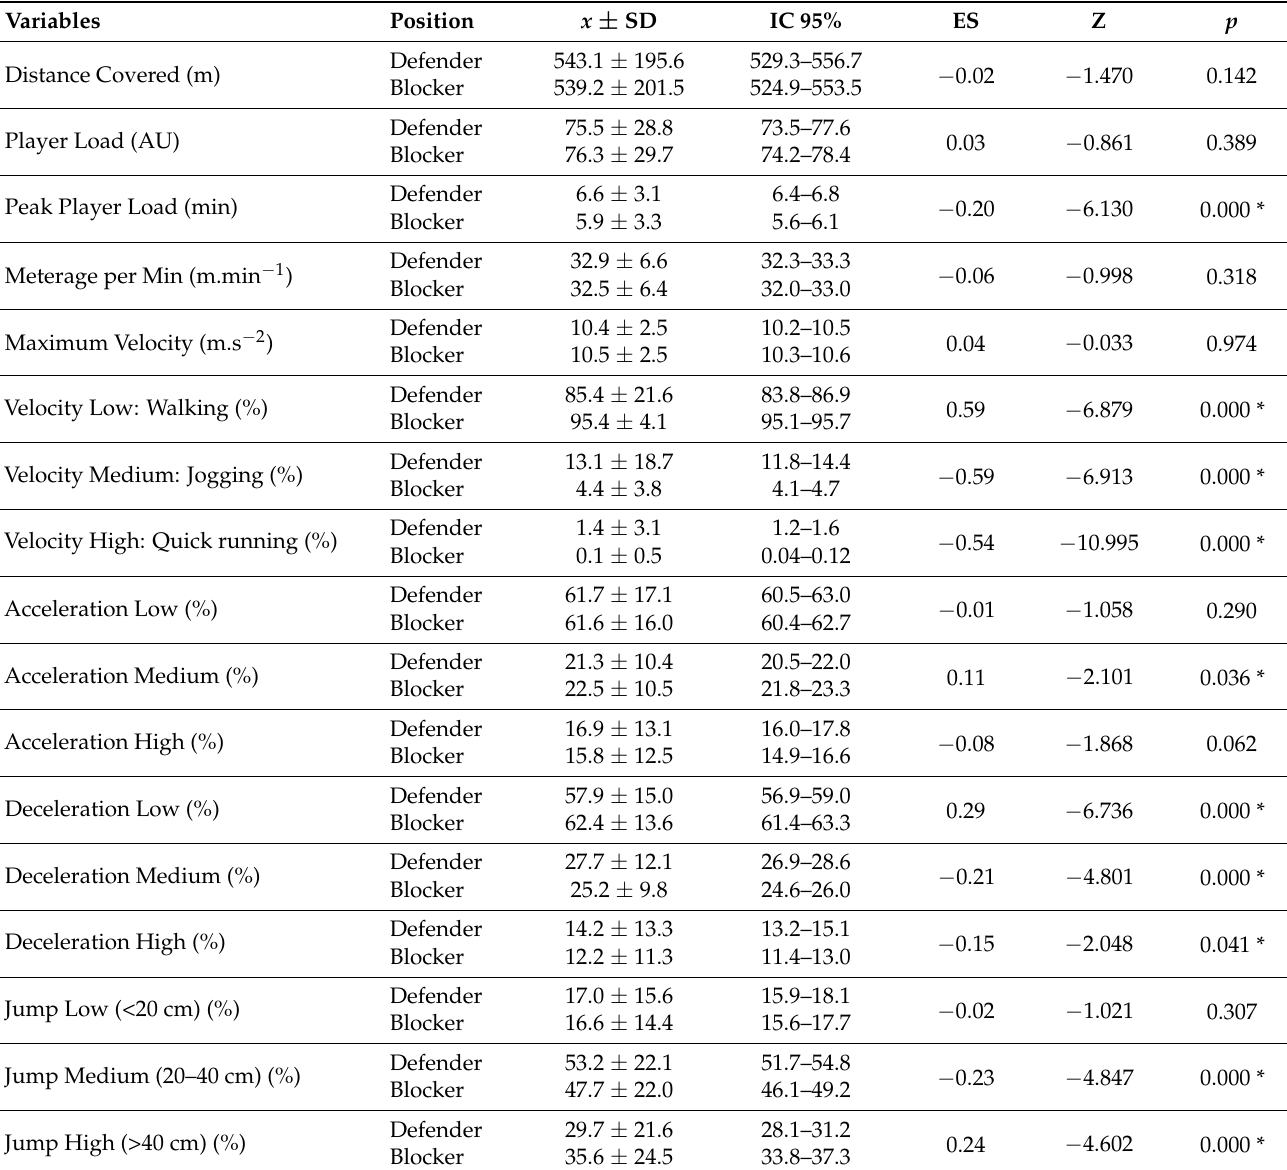
Table 2. Descriptive statistics ( x ± SD) and comparison of GPS variables according to the specific position (Defender and Blocker) in female beach